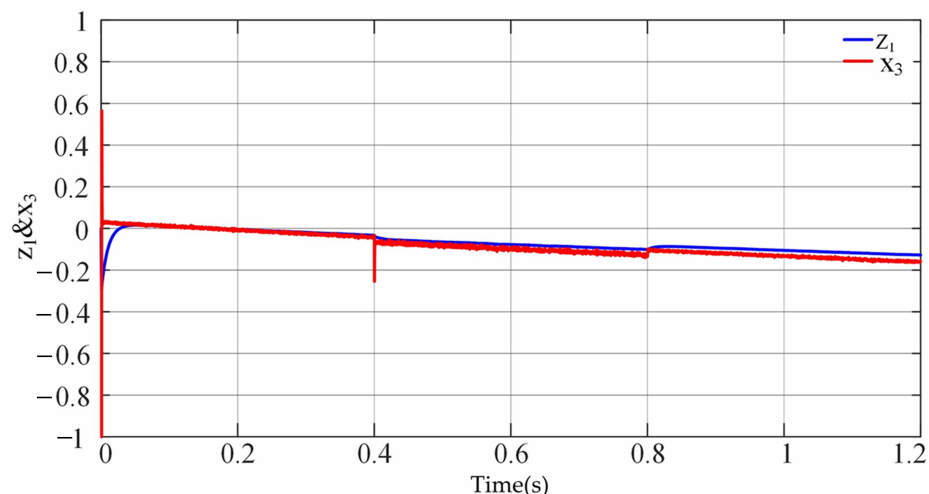
Figure 23. System state variable x 3 and estimated value z 1 .